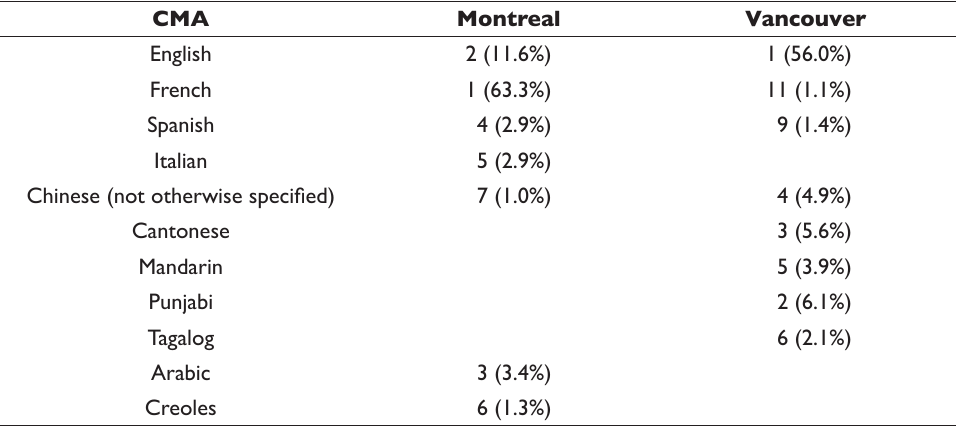
Table 2: MostspokenmothertonguesinMontrealandVancouver